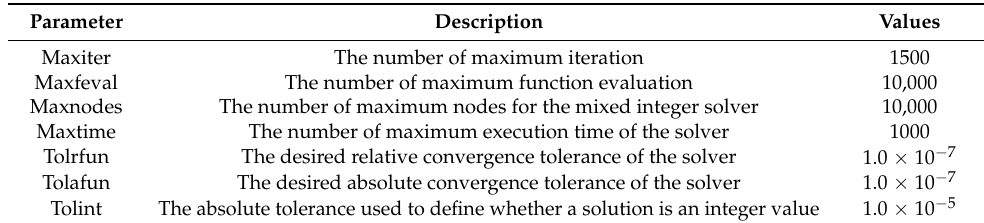
Table 5. Parameter settings for the